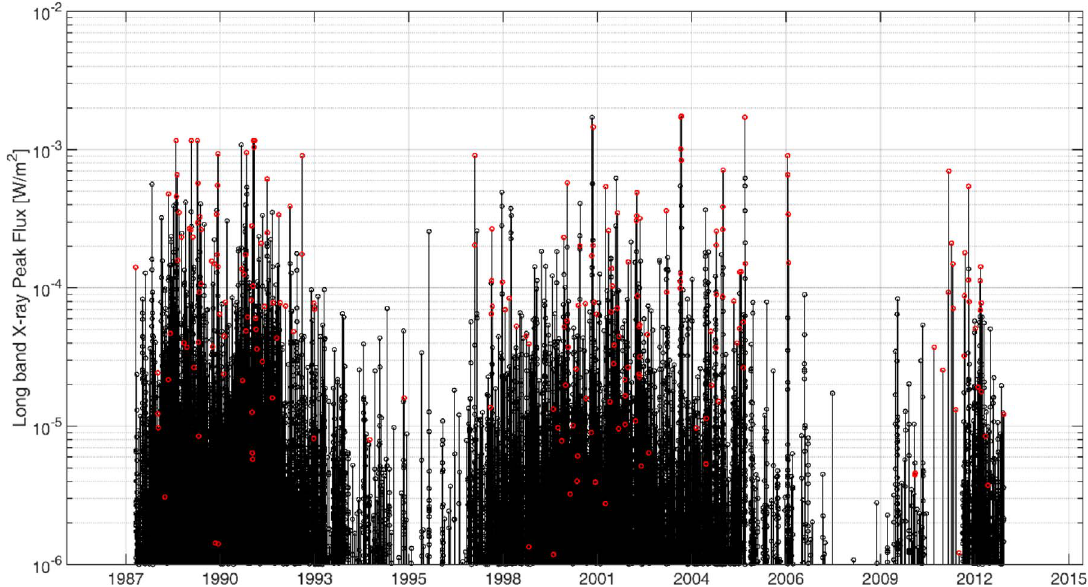
Fig. 1. X-ray Peak fl uxes in the long band of all solar fl ares used in this work for the 25-year time span. Flares that are associated with SEPs are marked in red